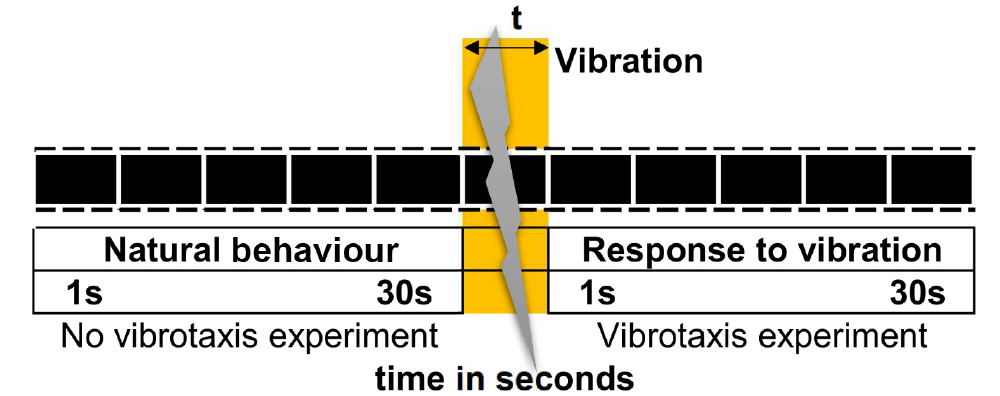
Figure 3. Before and after the vibration methodology. Image sequences: a continuous image recording at 1 fps for 30 s (natural behaviour), followed by vibration applied for t s, and finally another 30 s sequence when worm reaction was recorded.